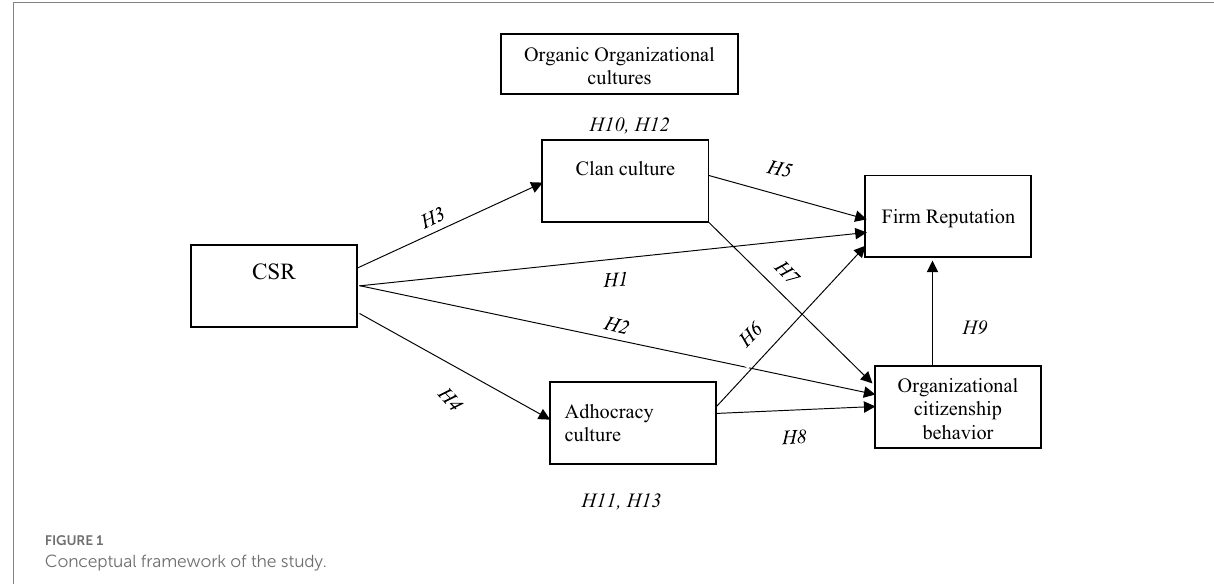
FIGURE 1 Conceptual framework of the